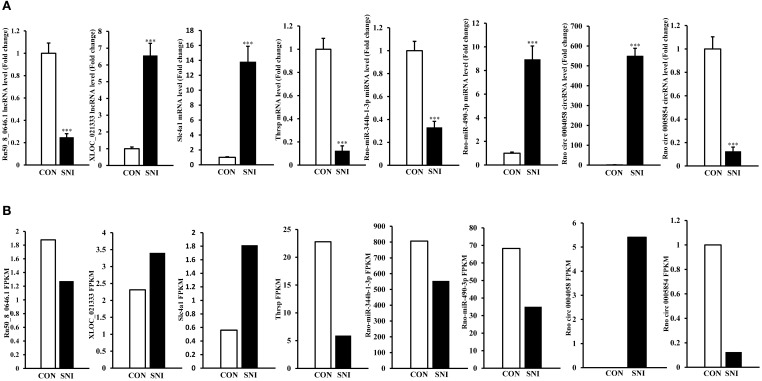
QPCR validations of eight regulated ncRNAs in the spinal cord from SNI rats. The expressions of lncRNAs, circRNAs, miRNAs and mRNAs (A) were significantly regulated at 14 days after SNI. One-way ANOVA followed by Tukey's multiple comparison test. ***P < 0.001. The sequencing results of corresponding lncRNAs, circRNAs, miRNAs and mRNAs with qPCR verification were showed in (B).